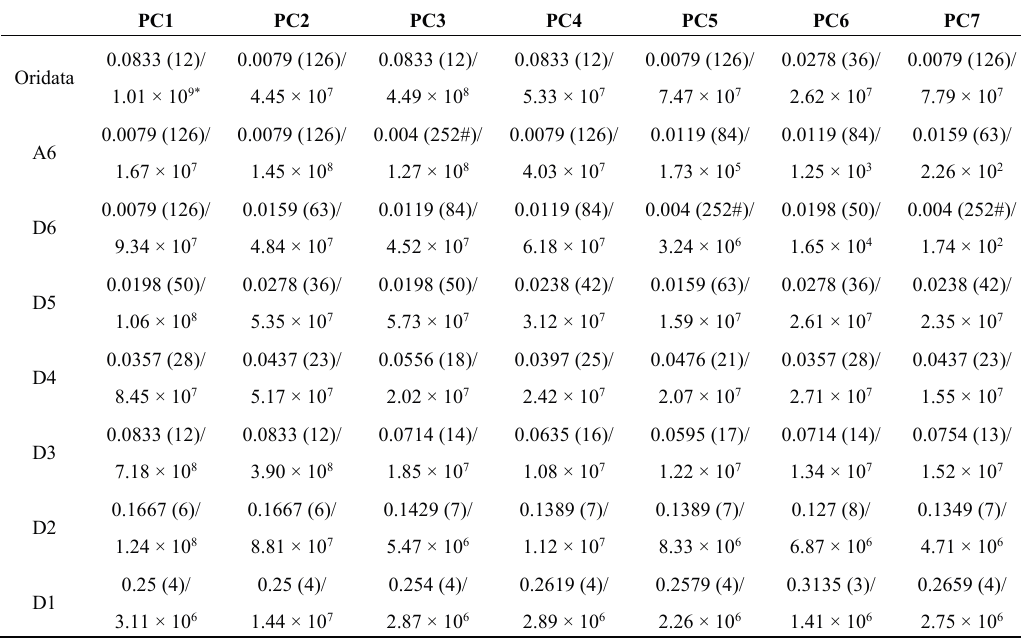
Table 2. Peak of PSD and corresponding frequency.